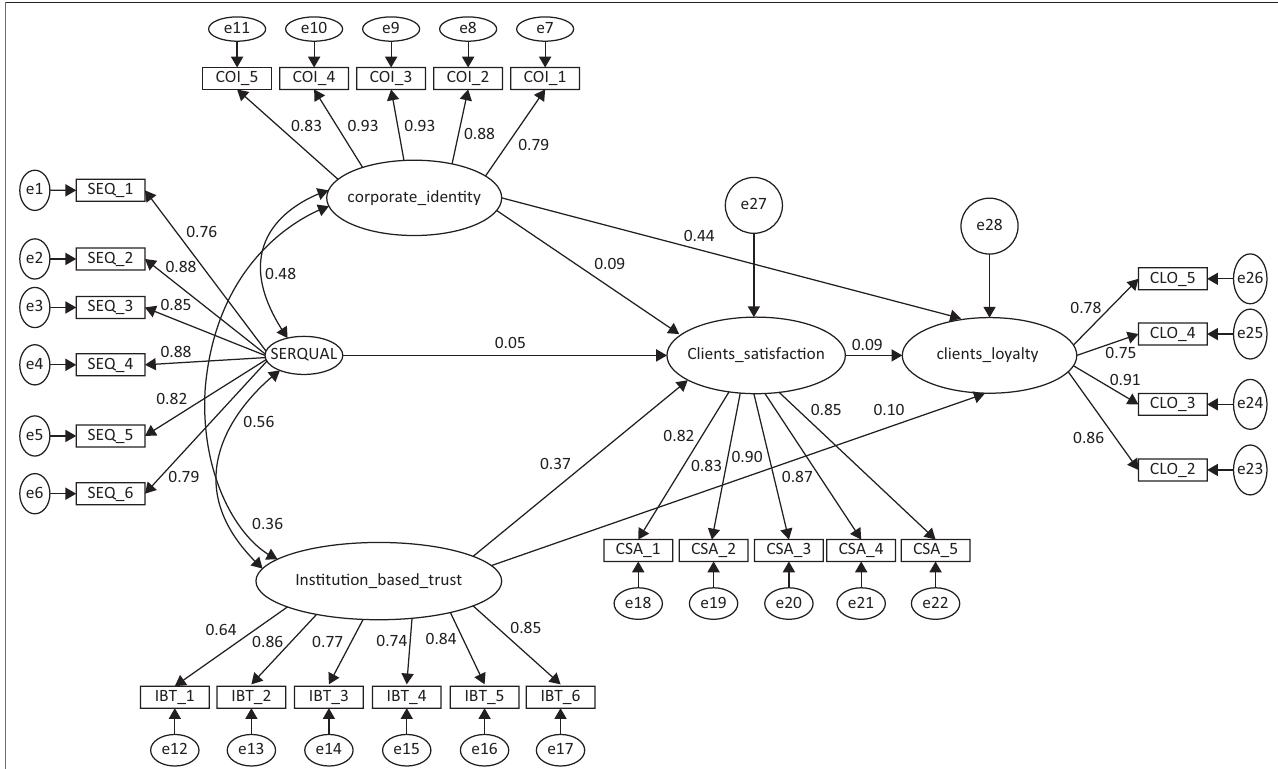
FIGURE 4: The structural model from AMOS graphics. TABLE 8: Factor correlation matrix of factor loadings.